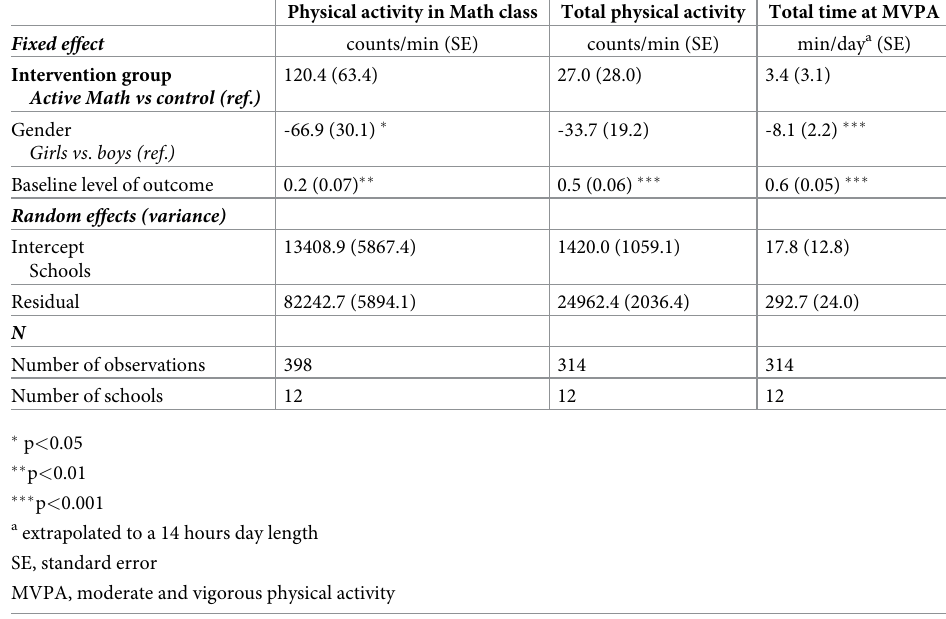
Table 3. Difference at follow-up between intervention and control in selected physical activity outcomes— adjusted for baseline level of the outcome, sex and school as random effect. Mixed effect model